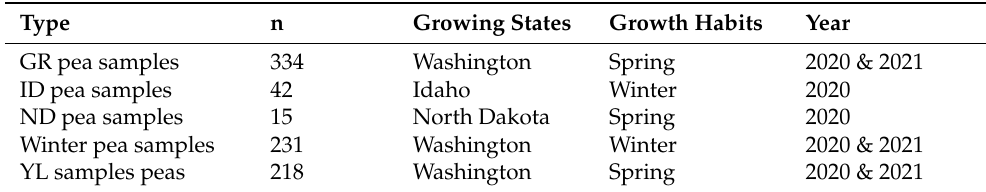
Table 1. Composition of pea samples utilized in the calibration of near-infrared spectroscopy to predict protein